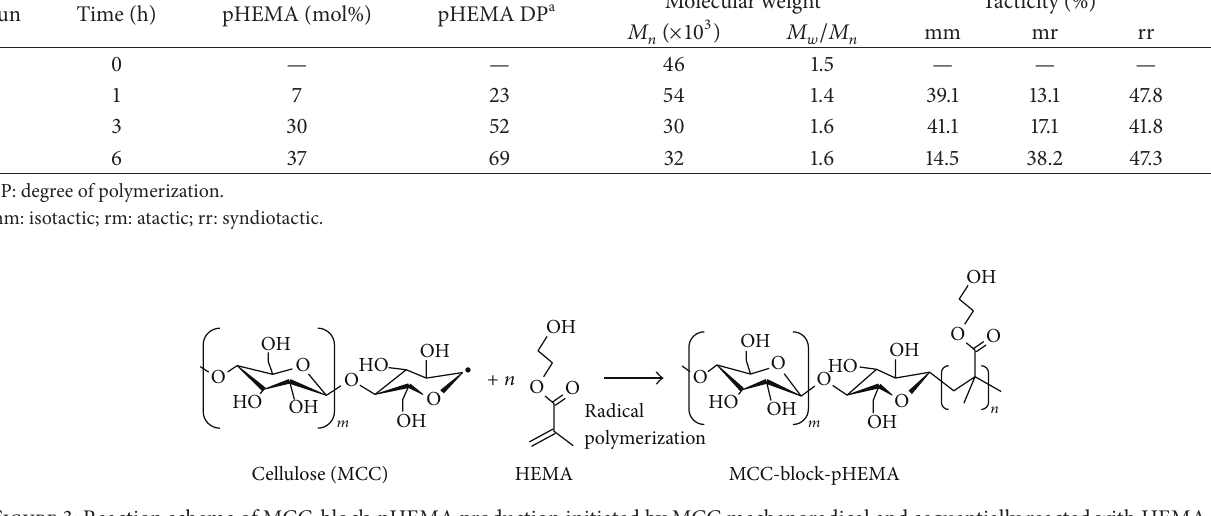
Table 1: Characteristics of MCC-block-pHEMA produced by mechanochemical polymerization.